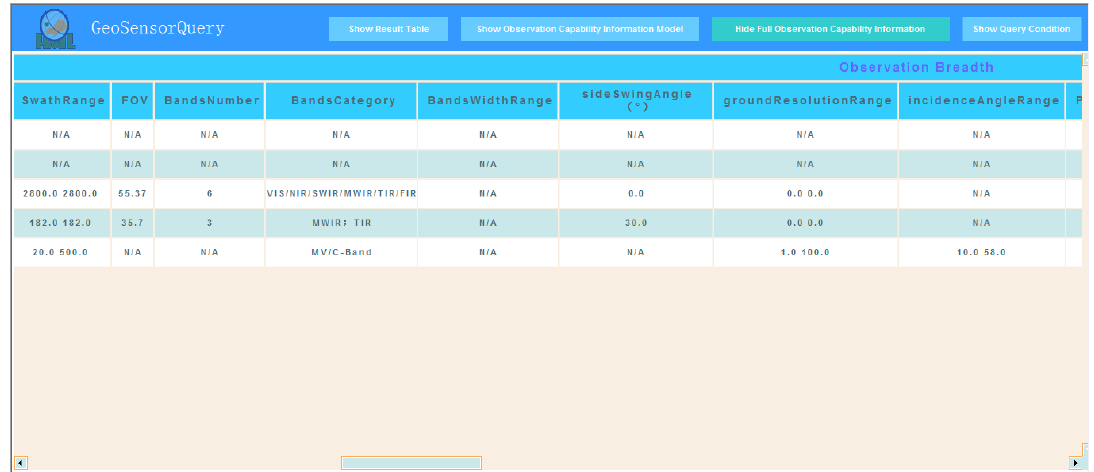
Figure 11. Sample of the overall representation of the observation capability information of all retrieved sensors.